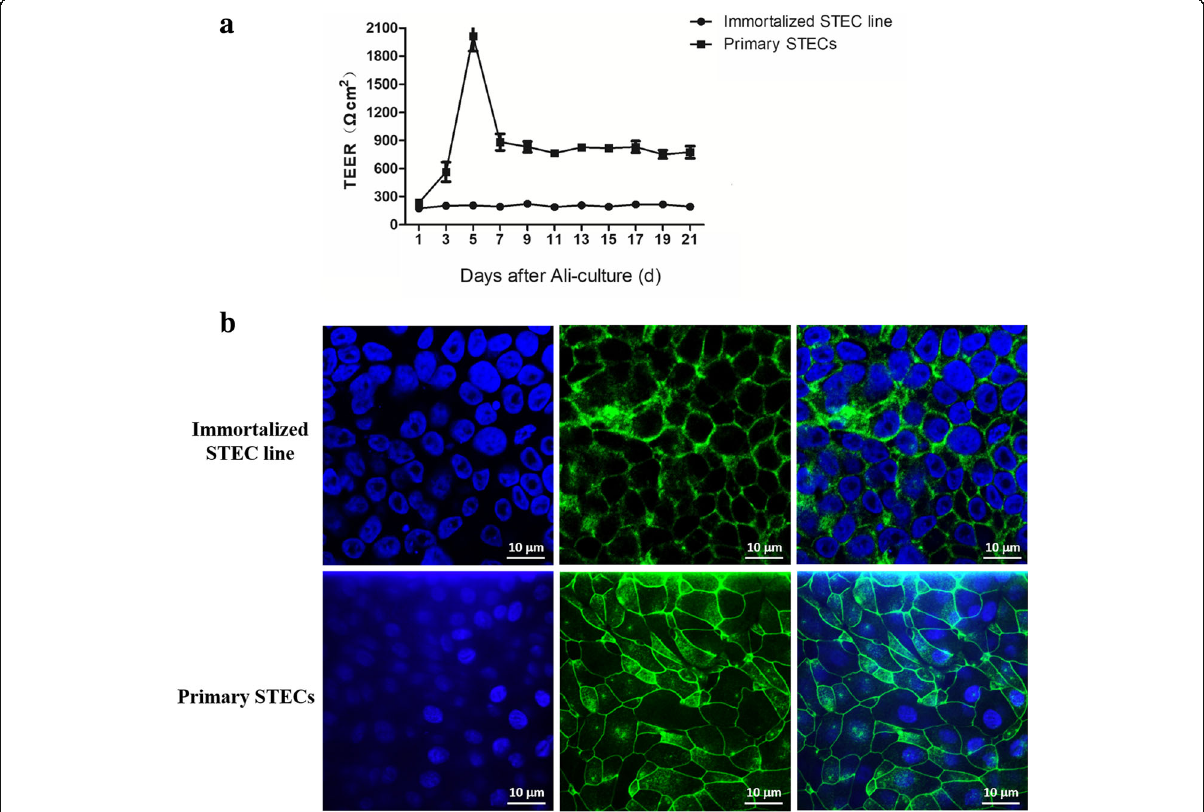
Fig. 2 Assessment of tight junctions in immortalized STEC line and primary STECs cultured under Ali conditions. Immortalized STEC line and primary STECs were cultured under Ali conditions for 21 days. TEER was measured on D1 and every 2 days thereafter through D21 under Ali conditions. Data are presented as resistance values ( Ω cm 2 )and given as the mean +/ − SD of three independent experiments, each done in triplicate ( n = 9) ( a ). At D7, the cells were fixed with 4% paraformaldehyde and stained with an anti-ZO-1 antibody, followed by incubation with a Alexa Fluor 488-conjugated goat anti-mouse secondary antibody. The cells were then counterstained with DAPI and imaged using laser scanning confocal microscopy ( b